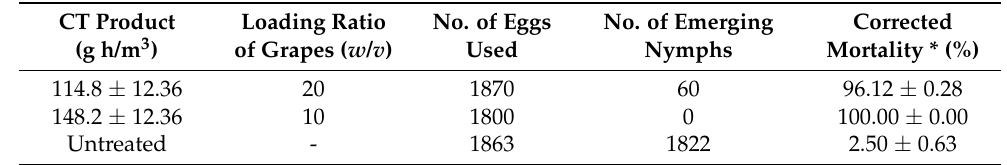
Figure 3. Concentration of EF inside and outside the packaging of grapes. The packaging consisted of low-density polyethylene film with small holes. Table 3. Large-scale (10 m 3 ) liquid ethyl formate fumigation (70 g/m 3 for 4 h at 5 ◦ C) of grapes (Campbell Early) to target Pseudococcus comstocki